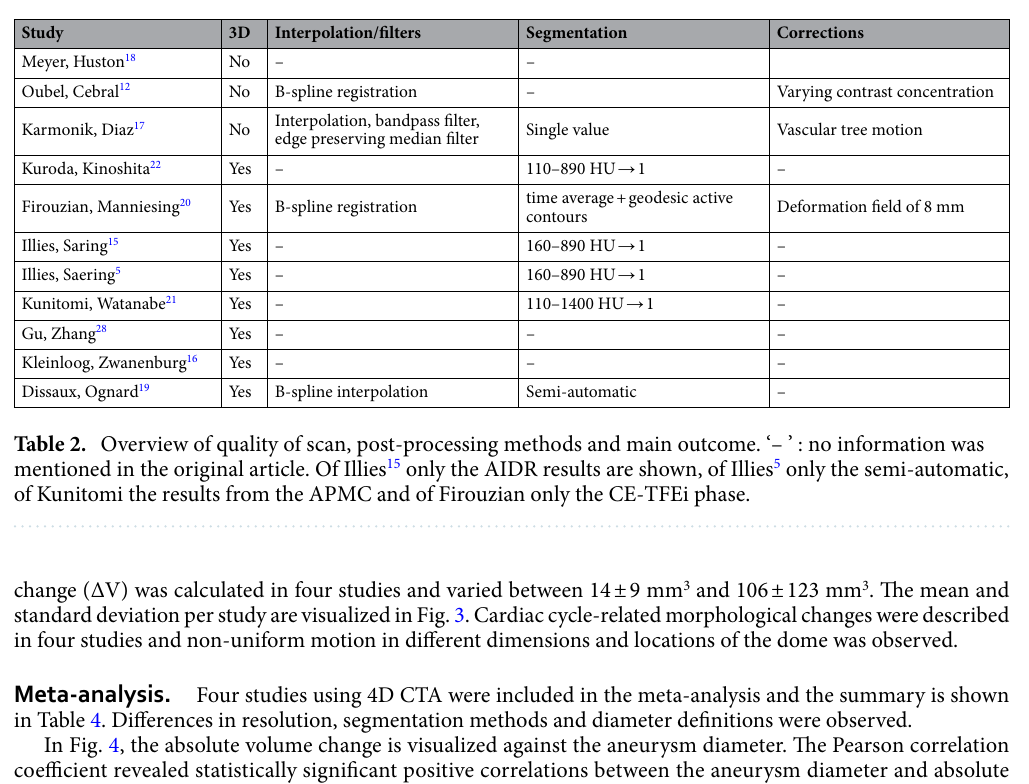
Meta-analysis. Four studies using 4D CTA were included in the meta-analysis and the summary is shown in Table 4. Differences in resolution, segmentation methods and diameter definitions were observed. In Fig. 4, the absolute volume change is visualized against the aneurysm diameter. The Pearson correlation coefficient revealed statistically significant positive correlations between the aneurysm diameter and absolute volume change in the studies of Illies 2016 (r = 0.81, P = 0.0003), Kunitomi (r = 0.88, P = 0.002) and Dissaux (r = 0.90, P < 0.0001). In Table 5, the mean size, absolute and relative volume change per location are listed for the four studies. In Fig. 5, the mean relative volume change is shown for each location.